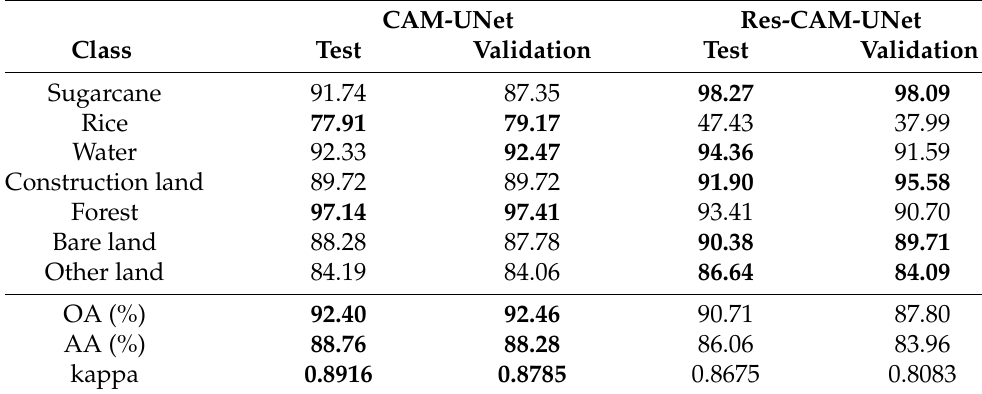
Table 4. Classification results of CAM-UNet and Res-CAM-UNet in the test set and validation